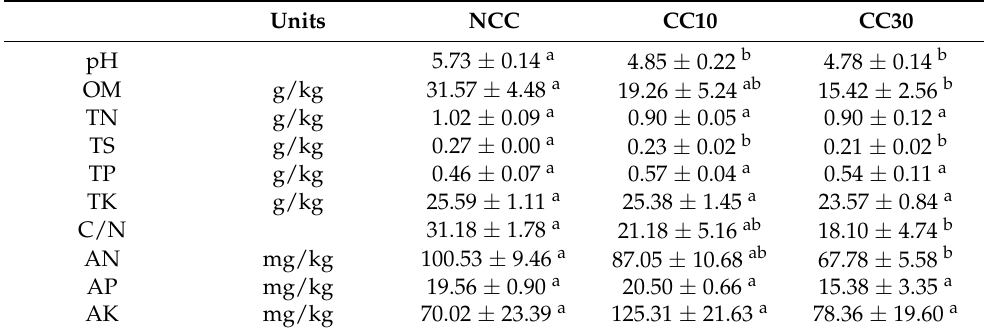
Table 2. Soil physiochemical